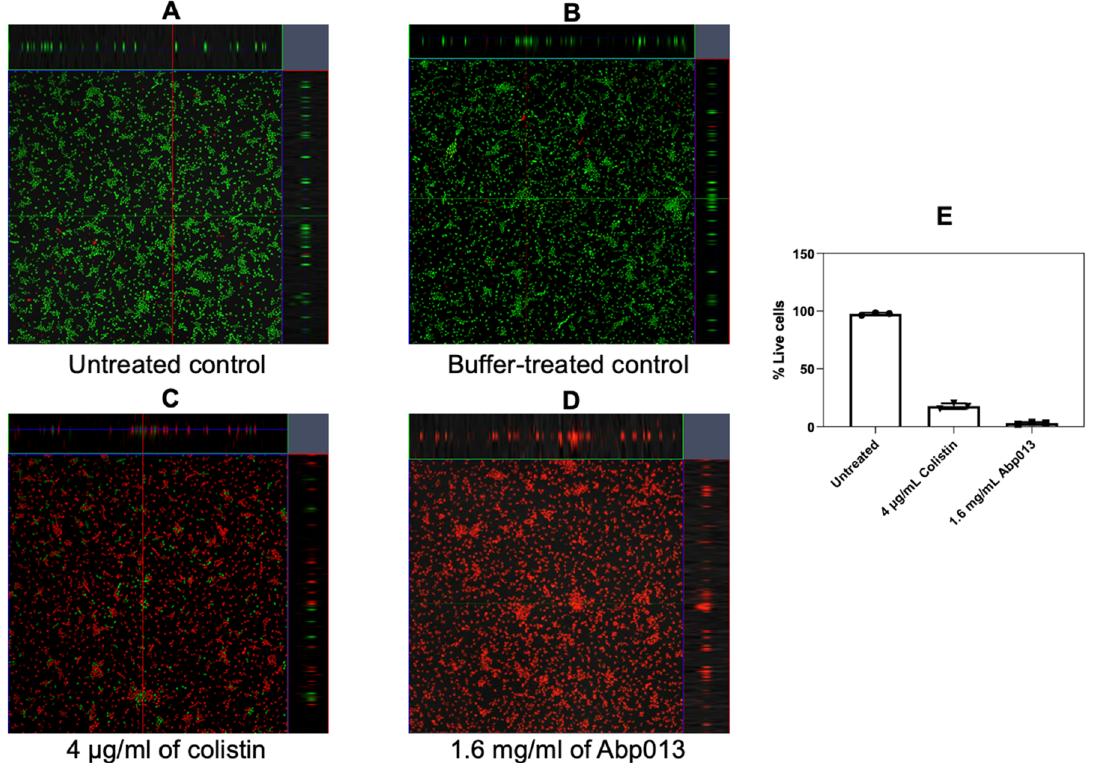
Figure 5. Representative confocal image of untreated control ( A ), buffer-treated control ( B ), 4 μ g/mL of colistin ( C ), and 1.6 mg/mL Abp013 ( D ), and the corresponding percentage of live cells ( E ) based on the analysis of at least 3 images for each treatment sample.